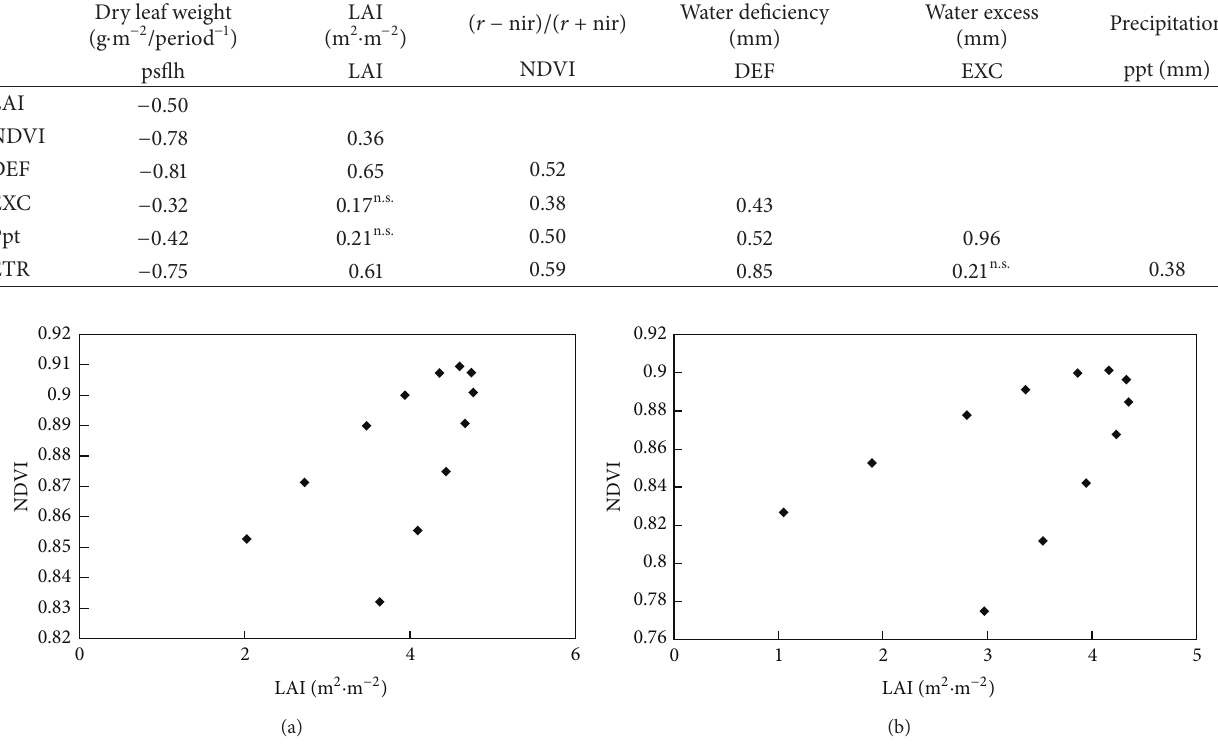
Table 4: Pearson correlation, ( ns nonsignificant at 0.05 of probability, 𝑛 = 85 ). Correlation of the LAI and the NDVI estimated data for the leaf collection dates using the polynomial equations adjusted to the LAI and the NDVI per fragment. Fragment 3 was removed from this analysis because of a different tendency in relation to the other fragments.